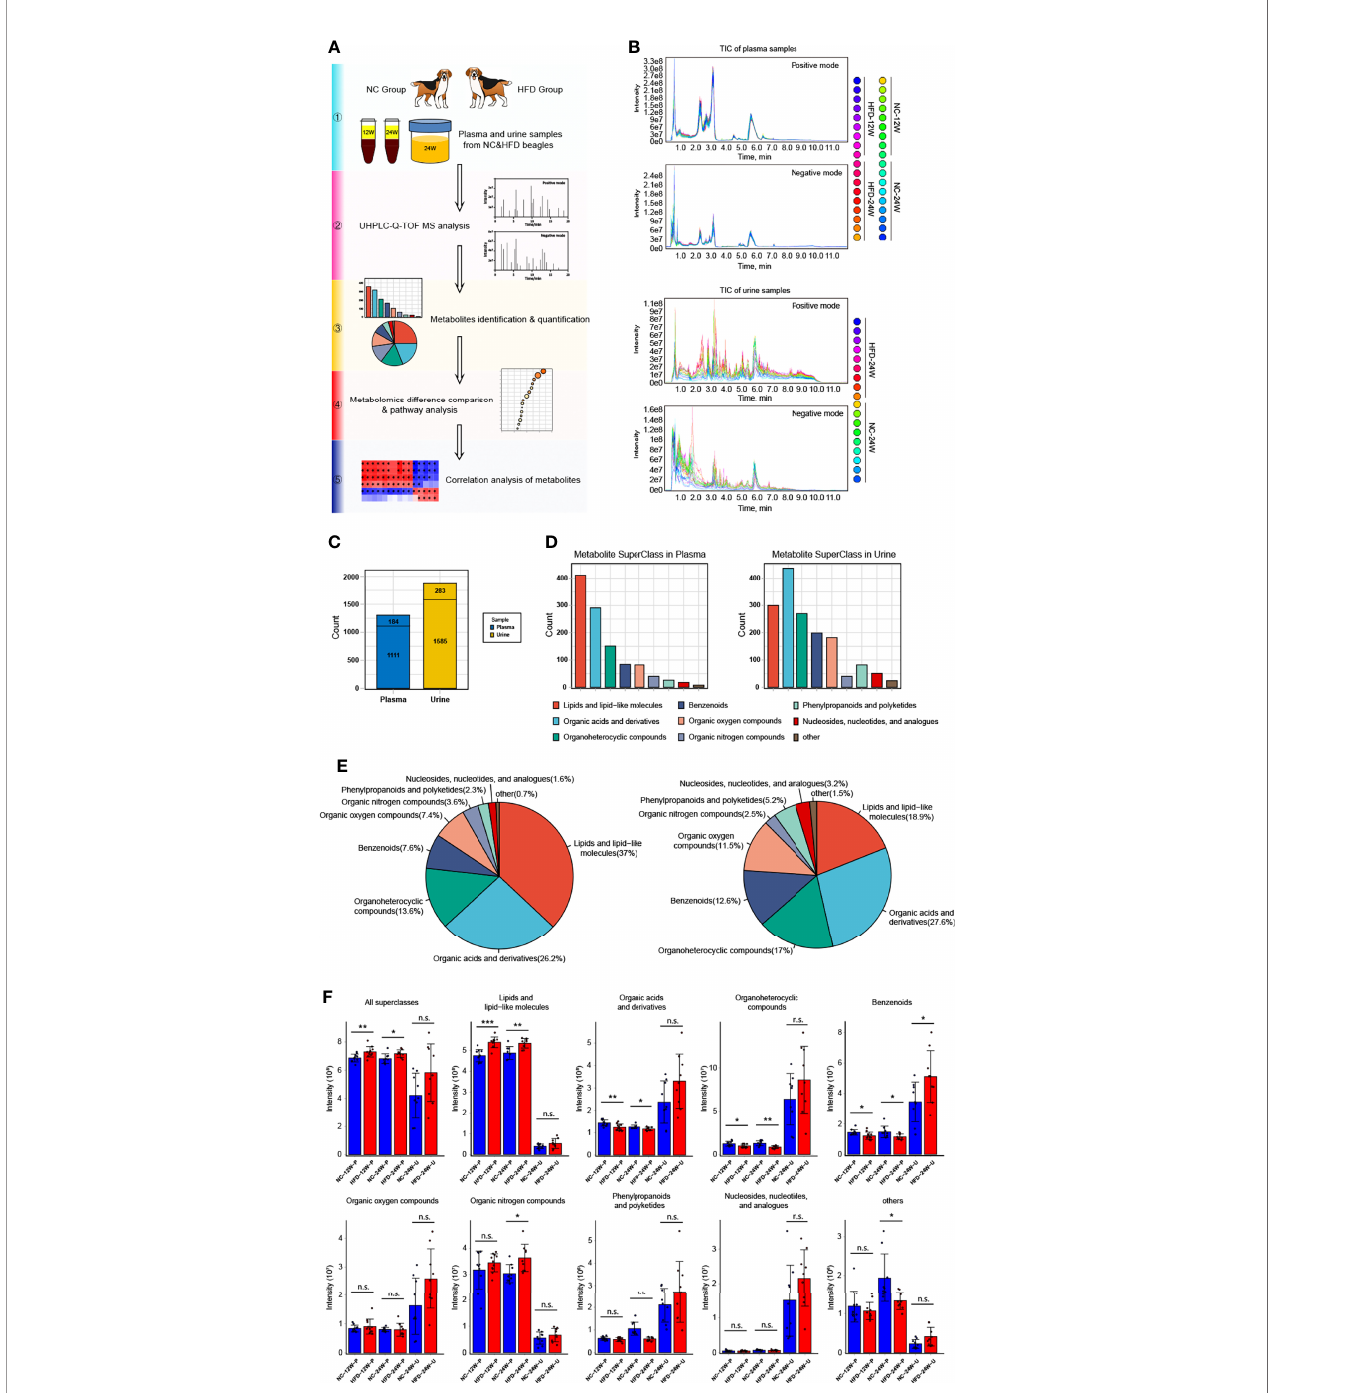
FIGURE 4 | Untargeted metabolomics analysis of canine plasma and urine samples relying on UHPLC-Q-TOF MS. (A) Scheme for the complete process of metabolite identi fi cation, classi fi cation, difference and pathway analysis, and correlation study of 12-week plasma as well as 24-week plasma and urine of NC and HFD dogs. n = 9 per group. (B) Plasma (top) and urine (bottom) samples overlapped with the total ion chromatogram (TIC) of quality control samples in positive and negative ion modes, respectively. (C) The total number of metabolites with or without the attribution information of chemical taxonomy detected in plasma and urine samples. (D, E) Statistics of all identi fi ed metabolites according to the attribution information of chemical taxonomy. The speci fi c number (D) and the proportion (E) of each metabolite superclass in plasma (left) and urine (right) samples are presented, respectively. (F) Relative intensity of the mass spectrometry signal of each metabolite superclass identi fi ed in plasma and urine samples from the two groups. n = 9 per group. Data are expressed as the mean ± SD. n.s. represents not statistically signi fi cant. Signi fi cance levels * P <0.05, ** P <0.01, *** P